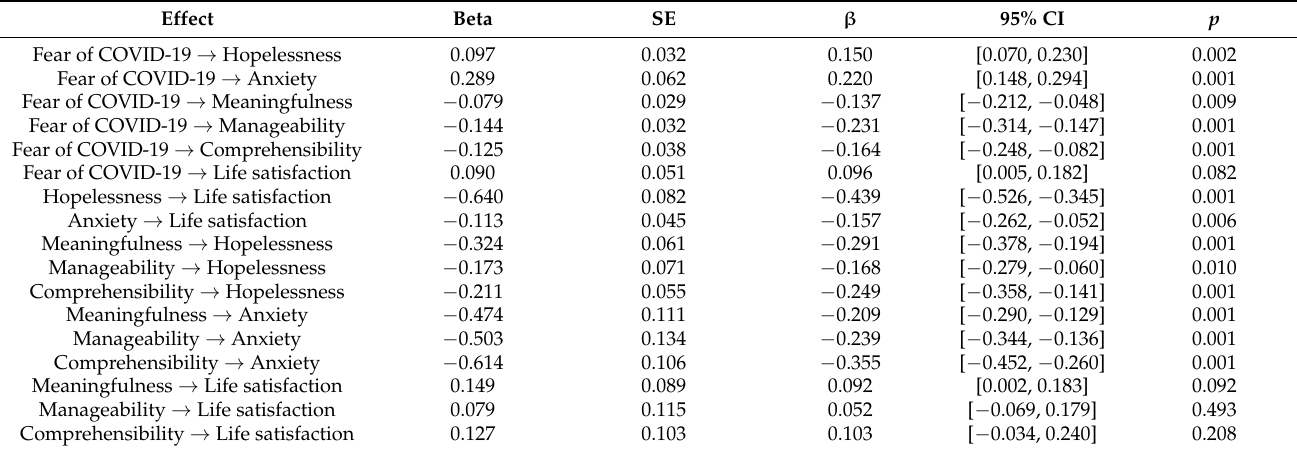
Table 2. Direct effects of predictors within the serial